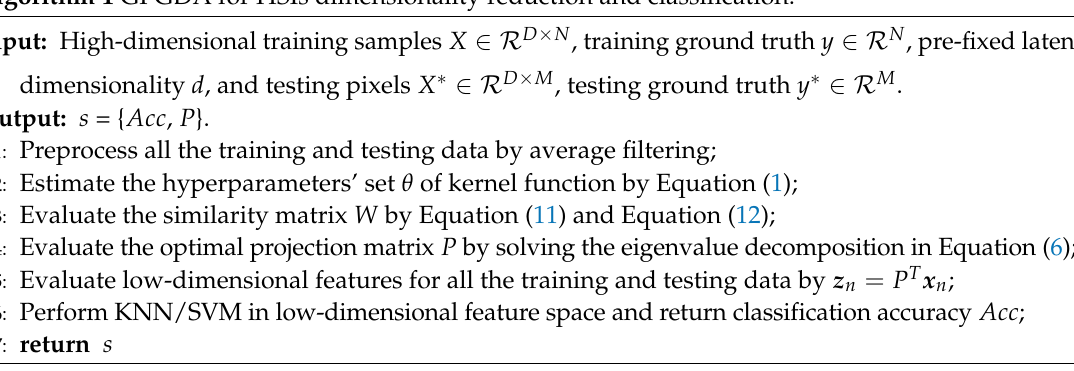
Algorithm 1 GPGDA for HSIs dimensionality reduction and